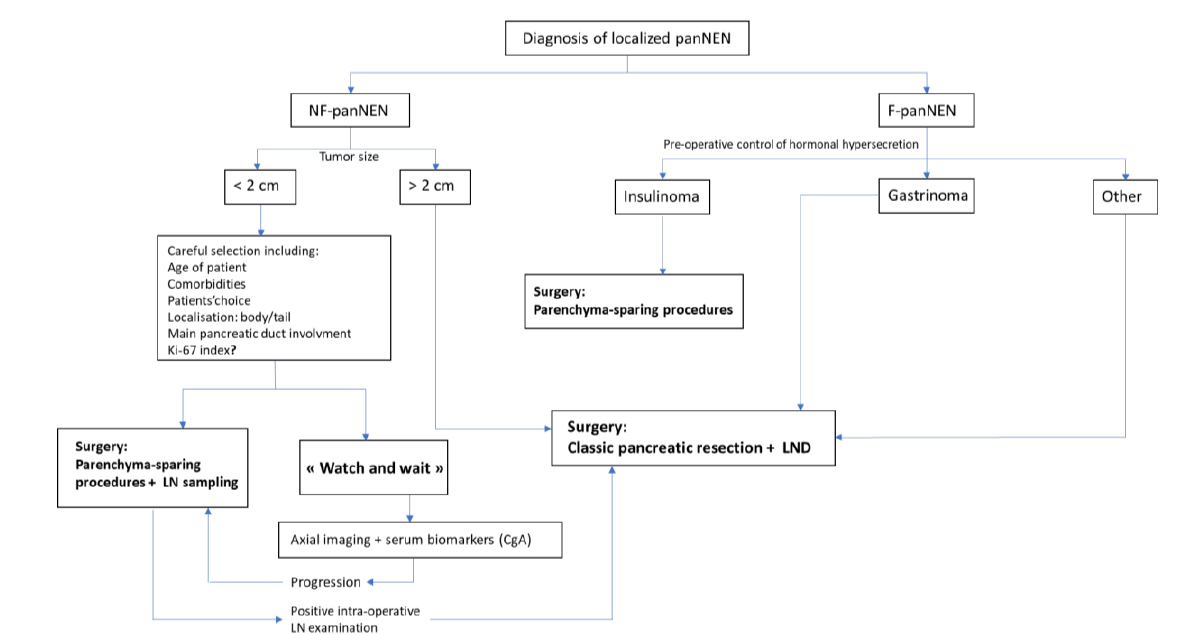
Figure 1. Surgical management for sporadic localized NF-panNENs (Stage IA–IIB). F/NF-panNENs: Functional/non-functional pancreatic neuroendocrine neoplasms, LN: lymph node, LND: lymph node dissection, CgA: chromogranin A.